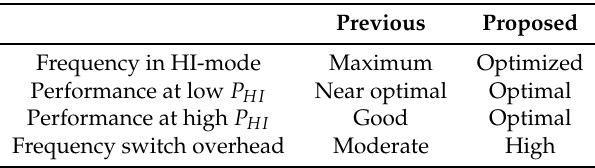
Table 5. Comparison summary.